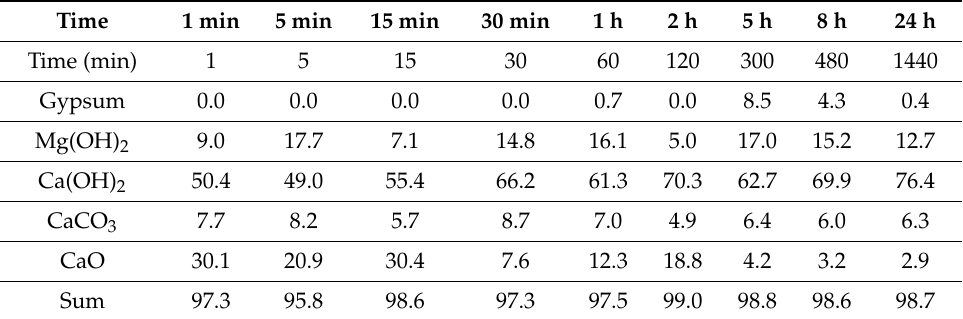
Table 7. Bulk composition (%) of solids from reaction of 1% fine CaO with sea water versus time at 5 °C for the first 24 h.